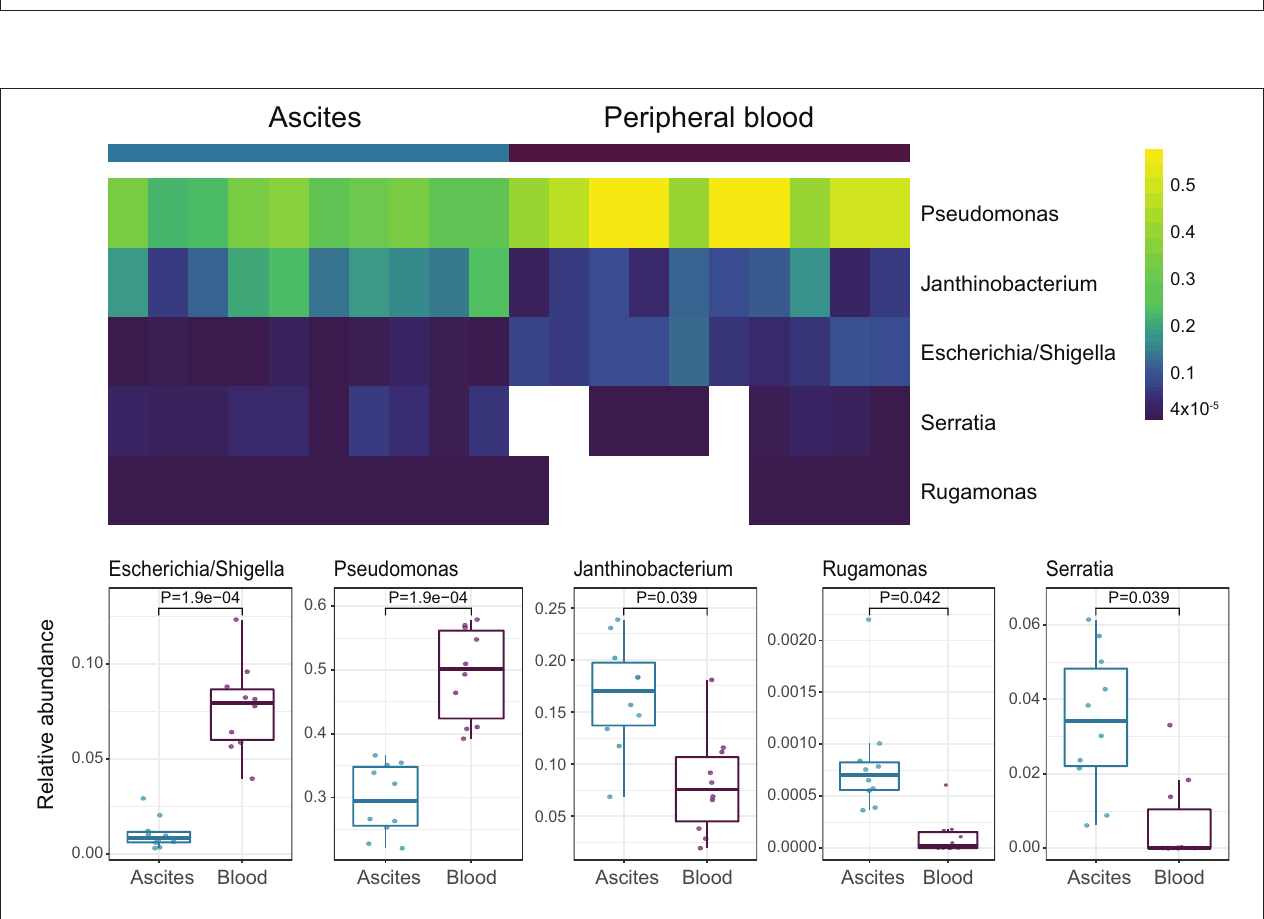
FIGURE 4 | Beta-diversity analysis. Principal coordinate analysis shows clear separation between ascites and peripheral blood samples, but samples do not cluster based on inflammation status. (A) Unweighted UniFrac (B) Weighted UniFrac.